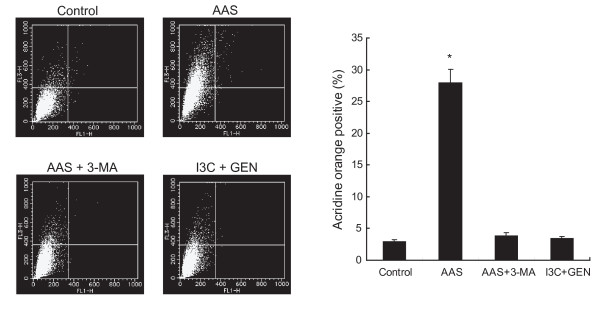
Co-treatment with I3C and genistein does not induce maturation of autophagosomes. Quantification of acidic vesicular organelles by acridine orange staining using flow cytometry. HT-29 cells treated with DMSO (control), amino acid-deprived medium (AAS) in the presence or absence of 3-MA (10 mmol/L), or the combination of I3C (300 μmol/L) and genistein (40 μmol/L) for 12 h were stained with acridine orange, and then subjected to a flow cytometric analysis as described in Materials and Methods. Left, FL1-H indicates the intensity of green fluorescence that is endogenous to the nucleus. FL3-H indicates the intensity of red fluorescence. Top of the grid was considered as AVOs. GEN, genistein. Right, Columns, mean (n = 3); bars, SD. *, P < 0.05, significantly different compared with the control.